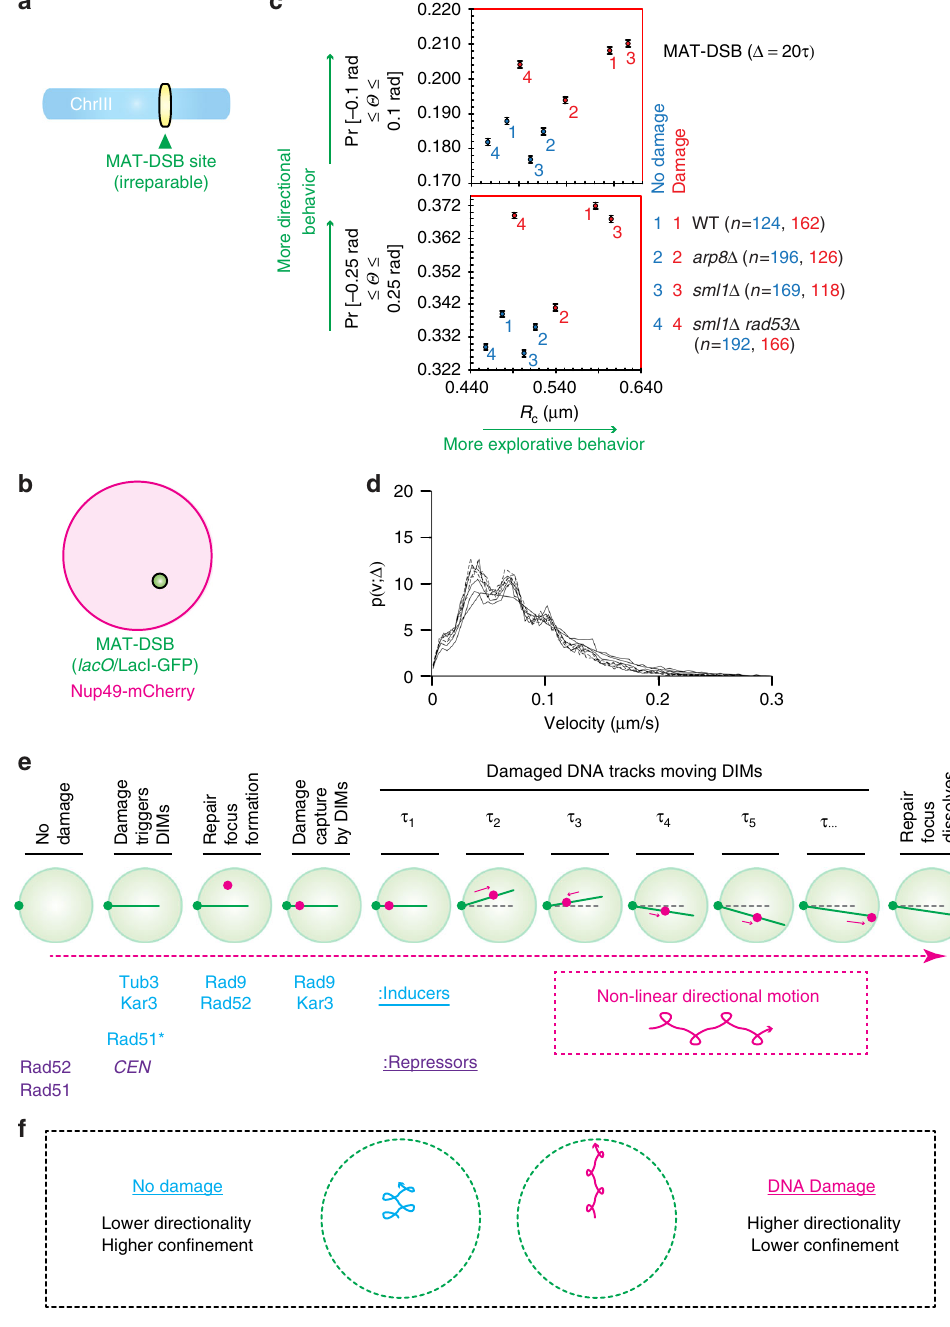
Fig. 4 Damage increases the directional motion of DNA. a , b MAT-DSB schematic ( a ) and system used to visualize it relative to the nuclear periphery ( b ). c For a single MAT-DSB locus that is imaged under DNA damaging or non-damaging conditions, the DCD-derived probabilities of the locus moving with up to 0.1 or 0.25 rad angle ( Θ ) deviation from a straight line were plotted relative to MSD-derived R c values. Error bars, DCD probability errors. d DCD-derived distributions of the velocities of the MAT-DSB locus under damaging and non-damaging conditions for the four cell types shown in c . Symbols are not shown as no difference was observed between the eight distributions. e DIM-dependent non-linear directional motion of damaged DNA in nuclear space. *Effect seen for MMS but not BIR-DSB. f Directionality and subnuclear exploration of intact and damaged